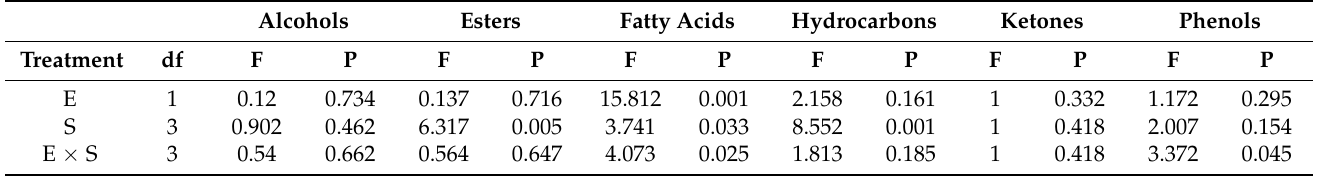
Figure 2. The proportion of alcohols ( a ), esters ( b ), fatty acids ( c ), hydrocarbons ( d ), ketones ( e ) and phenols ( f ) of leaf cuticular wax in Achnatherum inebrians according to the status of Epichloë gansuensis endophytes and in different growing periods (S1: 1 month after sowing, S2: 2 months after sowing, S3: 3 months after sowing, S4: 4 months after sowing, EI: endophyte-infected and EF: endophyte-free). Values are mean, with standard error bars ( n = 3). Columns with non-matching letters indicate a significant difference at p < 0.05. Table 1. Two–way ANOVA analysis showing the effects of the status of Epichloë gansuensis endophytes and different growing periods on the wax composition of the leaves of Achnatherum inebrians (E: the status of endophytes, S: developmental stages, E × S: the interaction between endophyte status and developmental